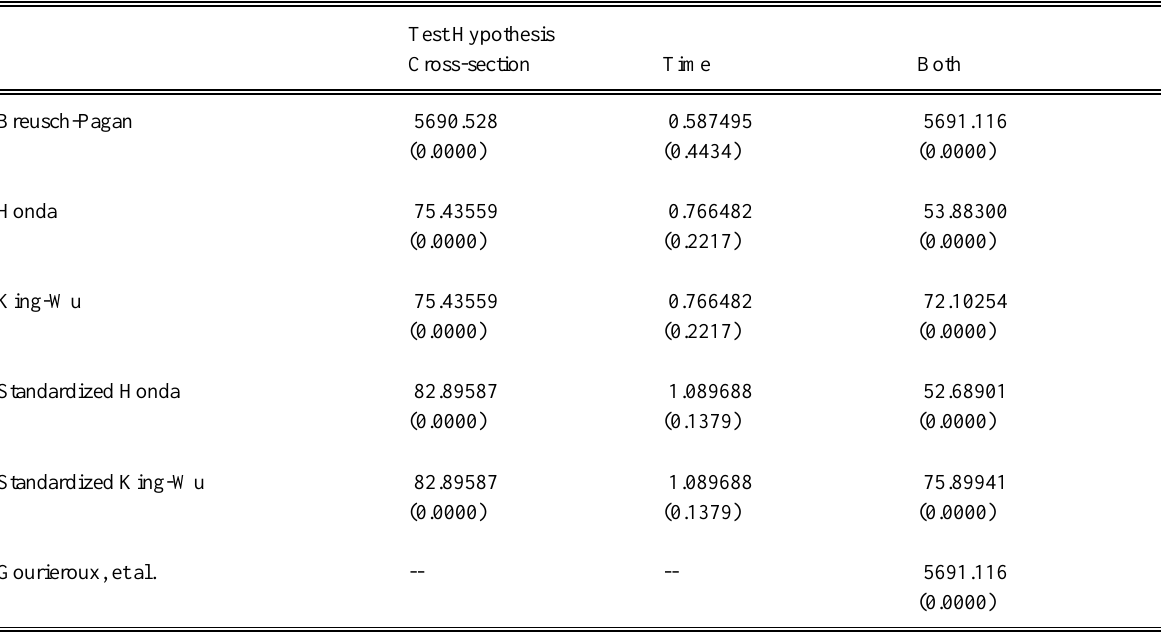
Table 4: Lagrange Multiplier